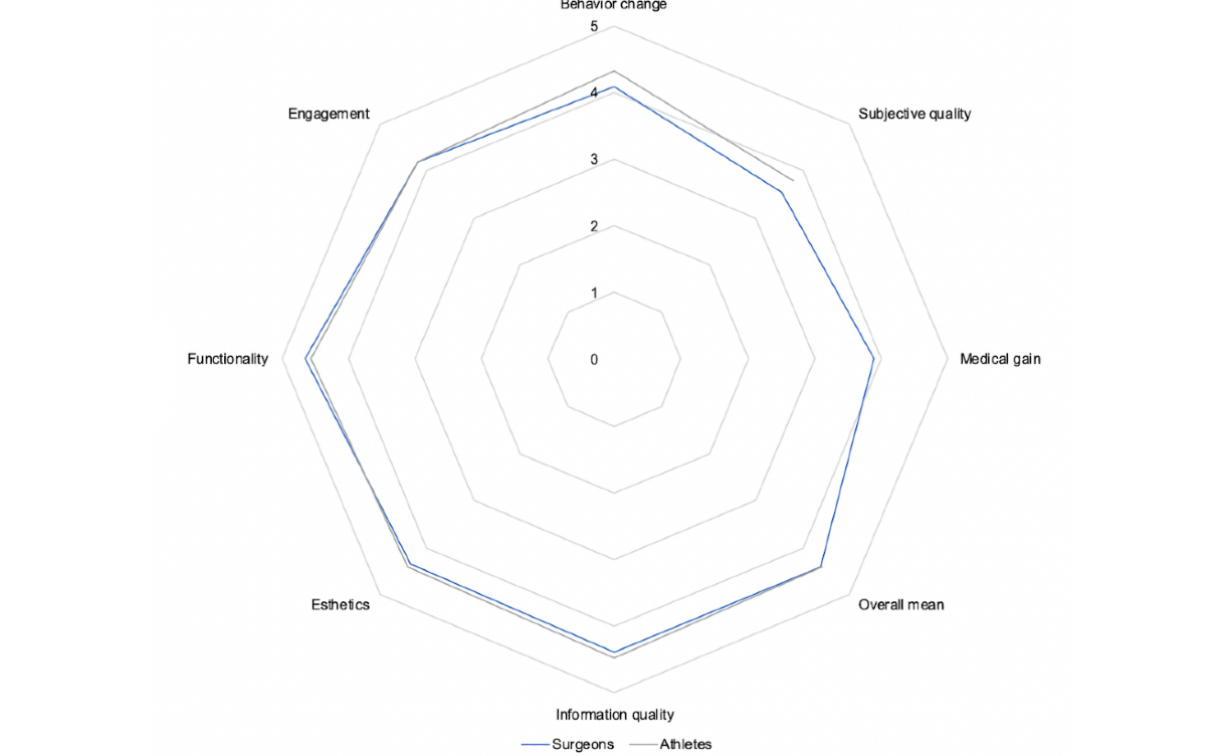
Figure 3. Mean scores of the (user) German Mobile App Rating Scale for the Ankle Joint App (surgeons: n=20 and athletes: